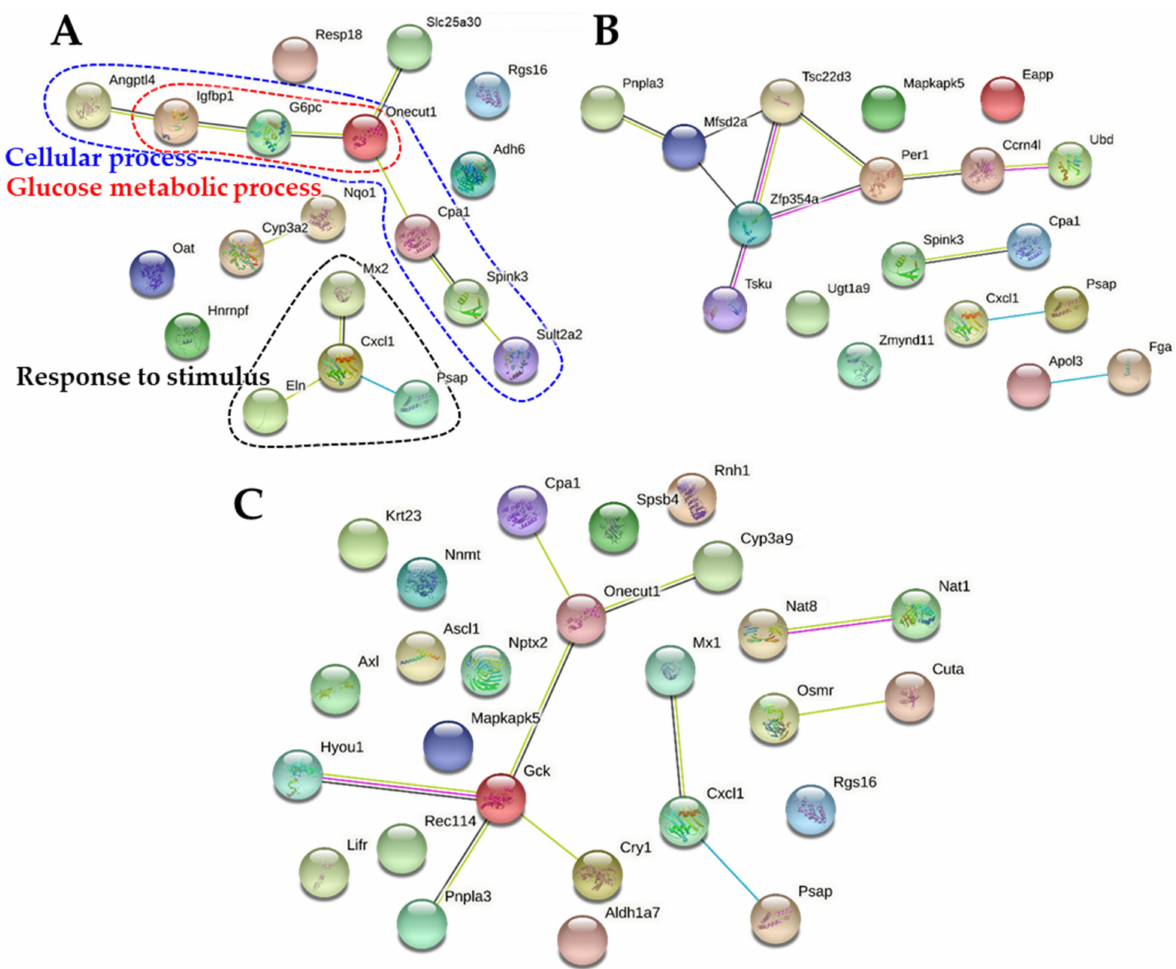
Figure 8. Protein-protein interaction (PPI) networks of down-regulated differentially expressed genes (DEGs) in the rat livers after 14-day repeated oral administration of ( A ) B-ZnO, ( B ) N-ZnO or ( C ) Zn